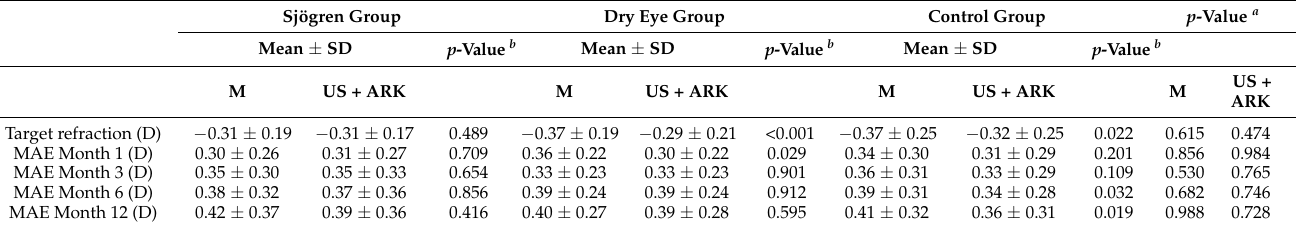
Table 4. Preoperatively Predicted Target Refractions and MAEs Calculated Using the Measurements of the IOLMaster and a Combination of Ultrasound Biometry and ARK.